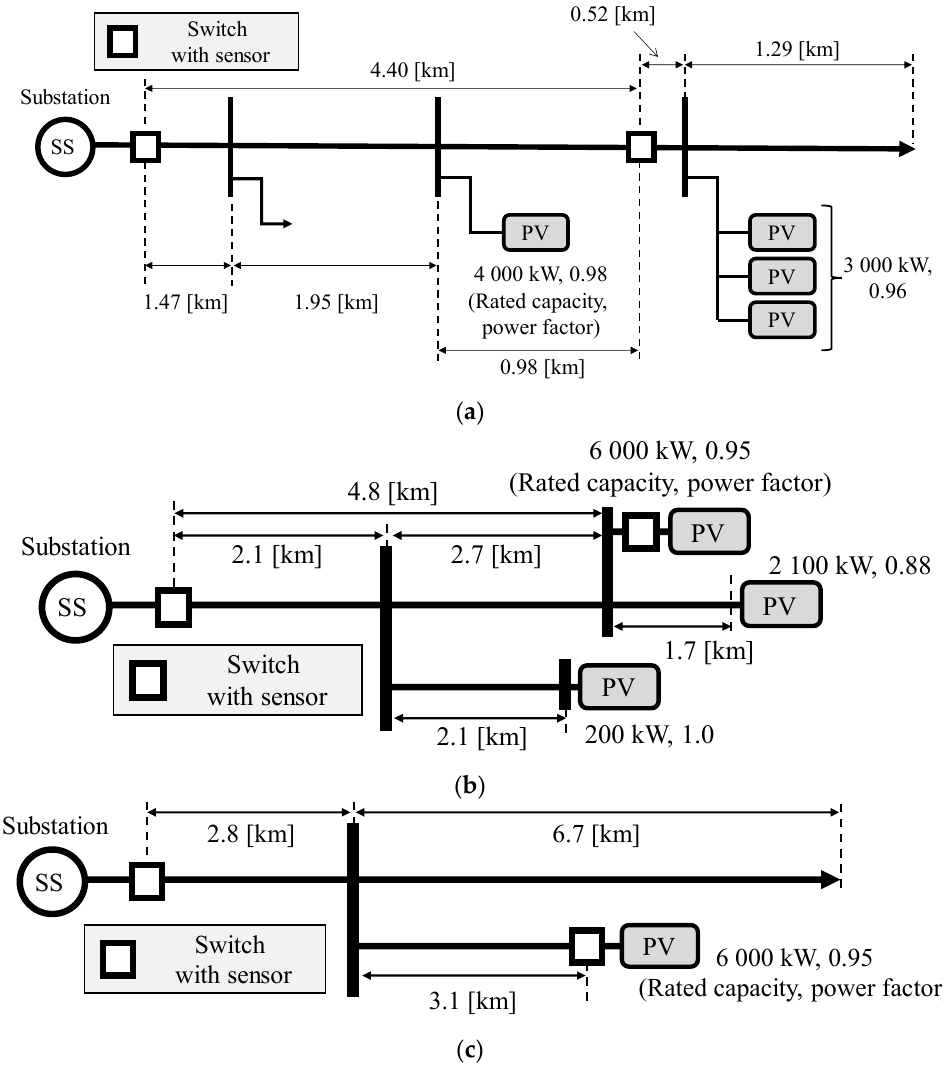
Figure 1. Medium voltage (MV) distribution feeder that measured voltage reduction due to large reverse power flow: ( a ) Feeder A; ( b ) Feeder B; ( c ) Feeder C.